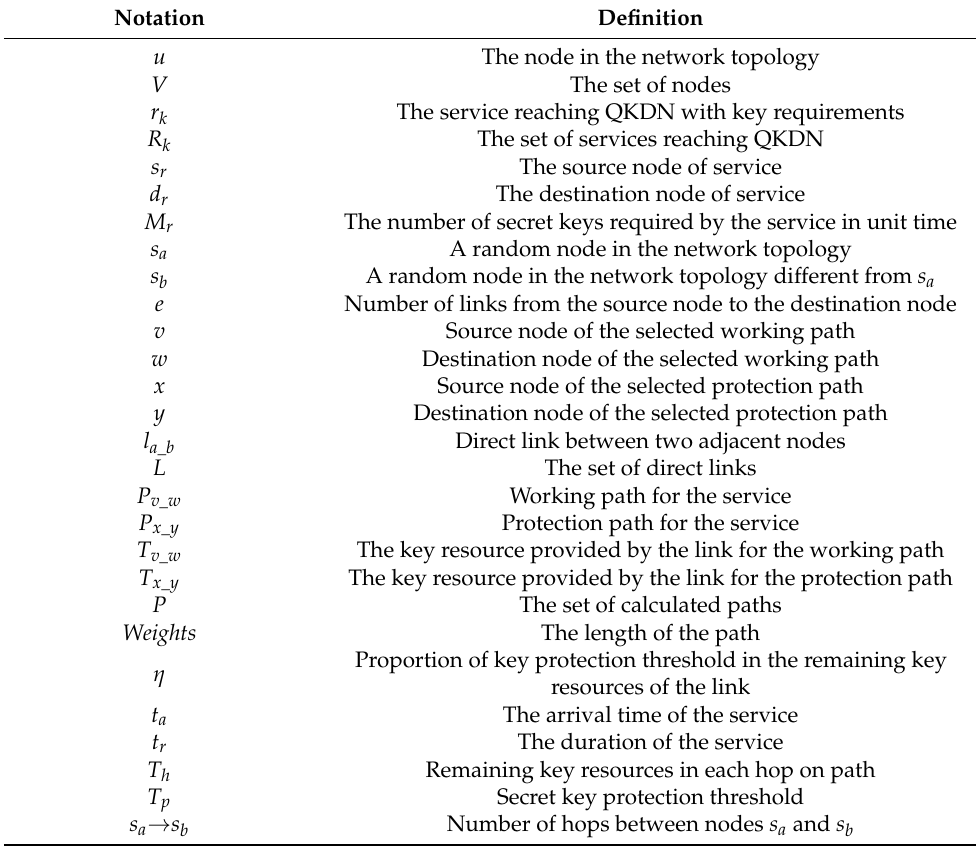
Table 1. Notation and